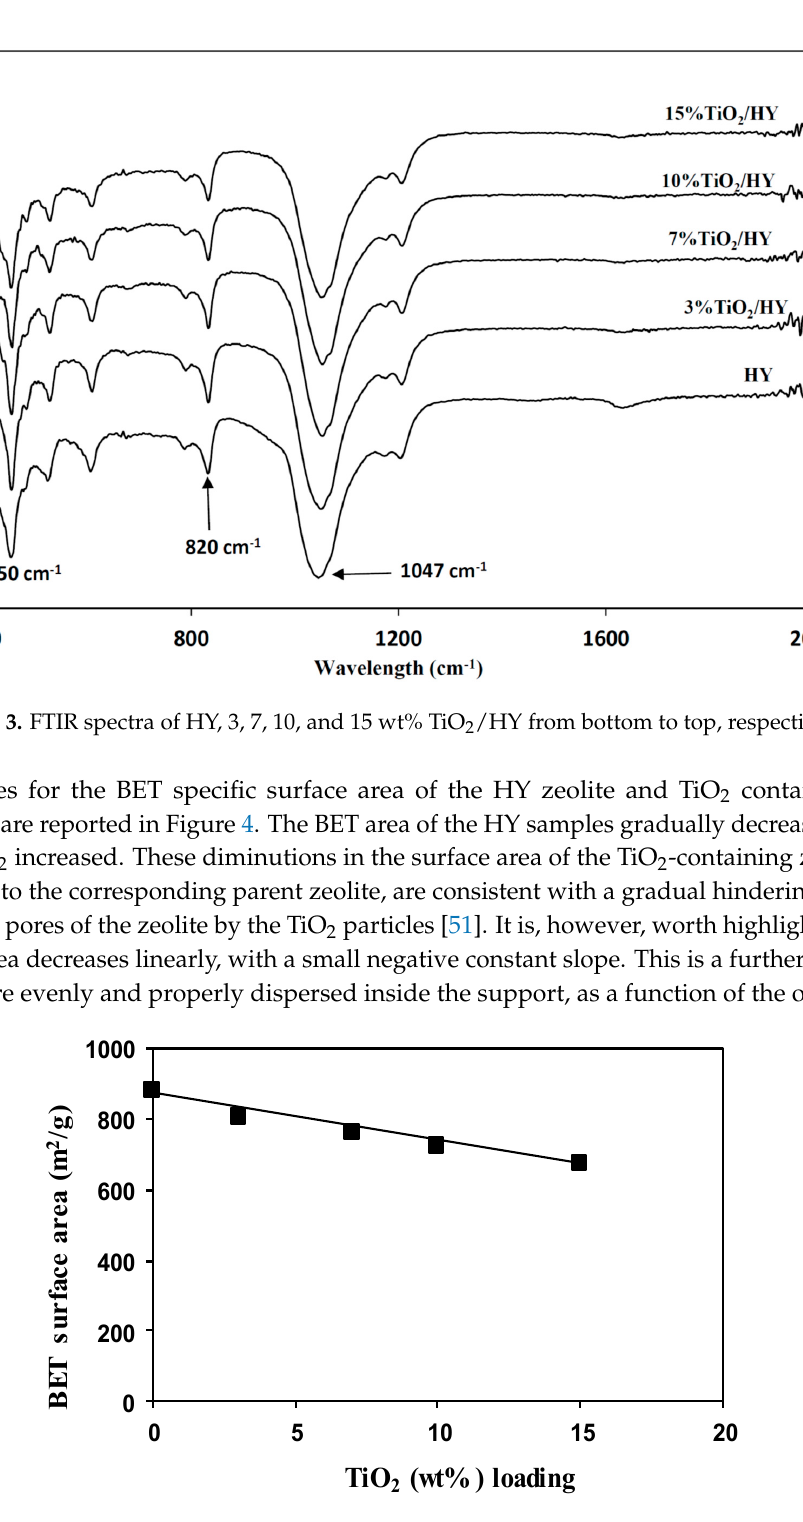
Figure 4. BET specific surface area vs. TiO 2 loading (wt%) on TiO 2 /HY zeolite